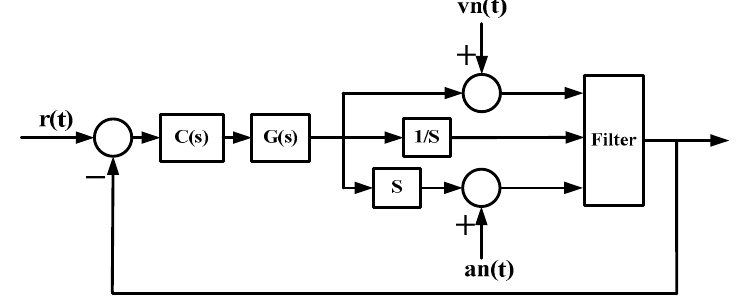
Figure 4. Simulation structure of the filtering algorithm.